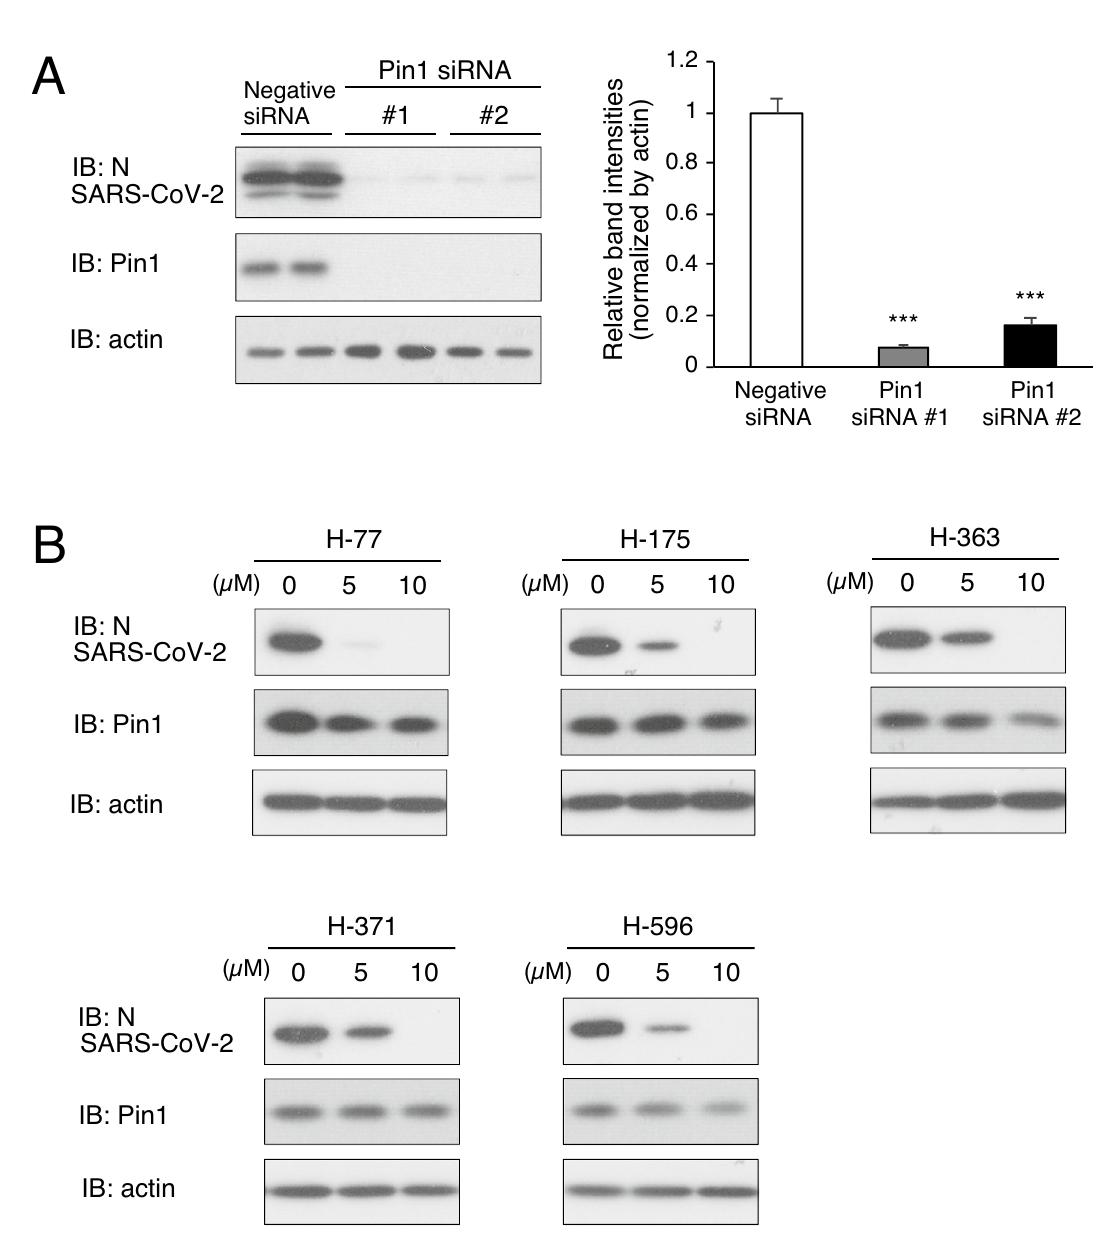
Figure 1. Both Pin1 knockdown and treatment with Pin1 inhibitors significantly reduced SARS-CoV-2 proliferation in VeroE6/TMPRSS2 cells. ( A ) VeroE6/TMPRSS2 cells were transfected with either Pin1 siRNA or negative siRNA, and after three days the cells were infected with SARS-CoV-2 at an input MOI of 0.01 followed by incubation for 24 h (n = 3–4). Cell lysates were processed for Western blotting with SARS-CoV-2 N, Pin1 and actin antibodies, and the bands are shown (Duplicate in the figure). The density of the N protein bands was quantitated, and relative density is shown in the graph with Negative siRNA as 1.0. *** P < 0.001, Mann–Whitney U test, compared with Negative siRNA. ( B ) The proliferation of SARS-CoV-2 in VeroE6/TMPRSS2 cells pretreated with 5 or 10 µM of each Pin1 inhibitor or 0 µM (DMSO). The cells were pretreated with a drug 2 h before infection and infected with SARS-CoV-2 at an MOI of 10, followed by incubation for 8 h in the presence of the drug. Cell lysates were processed for Western blotting using SARS-CoV-2 N, Pin1, and actin antibodies. Full-length blots are presented in Supplementary Fig.